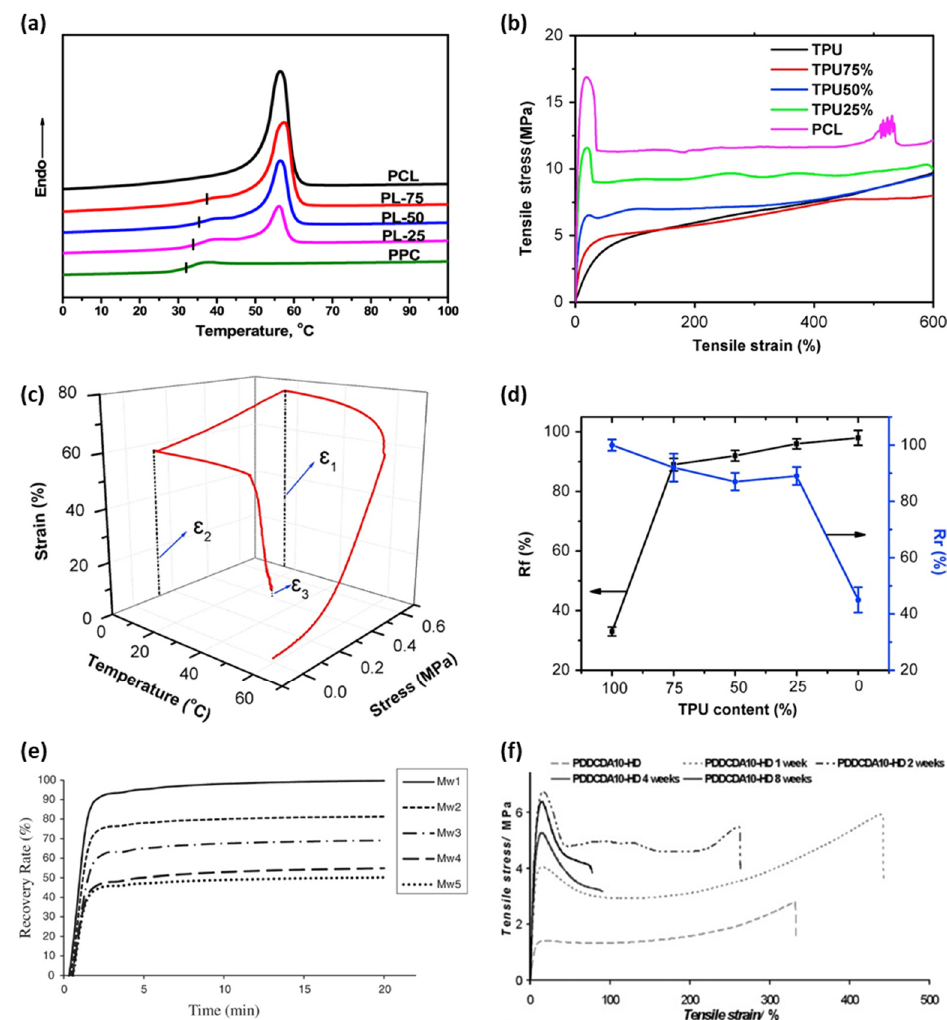
Figure 2. Thermomechanical properties and shape memory performance of BSMPs ( a ) DSC heating curves of PCL, PPC, and the PPC/PCL blends; (adapted with permission [53] ©2017, American Chemical Society) ( b ) stress–strain curves of TPU/PCL blends; ( c ) thermomechanical cyclic schematic of TPU25%; ( d ) shape memory performances of TPU25% (adapted with permission [40] ©2016, Elsevier Ltd.); ( e ) shape recovery rate curves of poly(caprolactone)/styrene-butadiene-styrene blend for different molecular weights by degradation (adapted with permission [54] © 2020, Wiley Periodicals LLC); ( f ) effect of polymer degradation on the mechanical properties of hydroxyl-dominant polymers (adapted with permission [65] ©2011, WILEY-VCH Verlag GmbH & Co. KGaA,